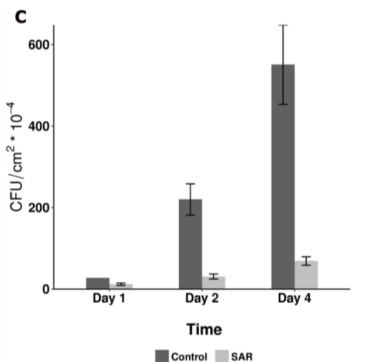
Figure 3. Aspecific feature of SAR induction in tobacco ( N. tabacum cv. Xanthi nc). TMV induced SAR response was effective not only against TMV and another viral (cucumber mosaic virus, CMV necrotic strain) ( A , B ) but bacterial ( Pseudomonas syringae pv. tabaci ) ( C ) pathogens as well. SAR was induced by TMV infection as described earlier [31] and 10 days later the 5th and 6th leaves were challenged by CMV (SAR-CMV) and TMV (SAR-TMV) as compared to controls (C-CMV and C-TMV) (half leaves of each case) ( A ) or by bacterial suspension (10 5 CFU mL − 1 ) ( C ) in triplicates per treatments. ( B ) Multiple comparison of means of selected treatments in ( A ). Dots represent the difference of the estimated means between treatments, brackets flank the 95% confidence intervals. The difference is considered significant if the confidence interval does not contain the 0, represented by a vertical dashed line [31]. ( C ) The SAR induction was also checked by TMV challenge inoculation (showing 69.6% significant inhibition of TMV lesion size). The TMV induced SAR caused time-dependent